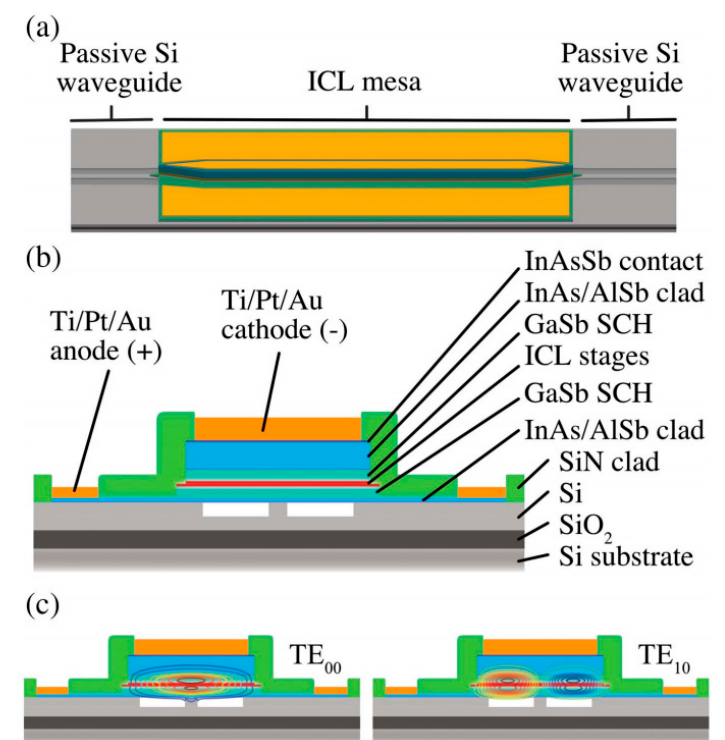
Figure 22. ( a ) 3D schematic of an ICL heterogeneously integrated on silicon, showing the tapered regions designed to couple light between the hybrid and silicon waveguides; ( b ) cross-sectional schematic of the hybrid III-V/Si active region; ( c ) active region cross-section overlaid with contour plots of the TE 00 and TE 10 electric field profiles. Reproduced from Ref. [220], with the permission of OSA Publishing.